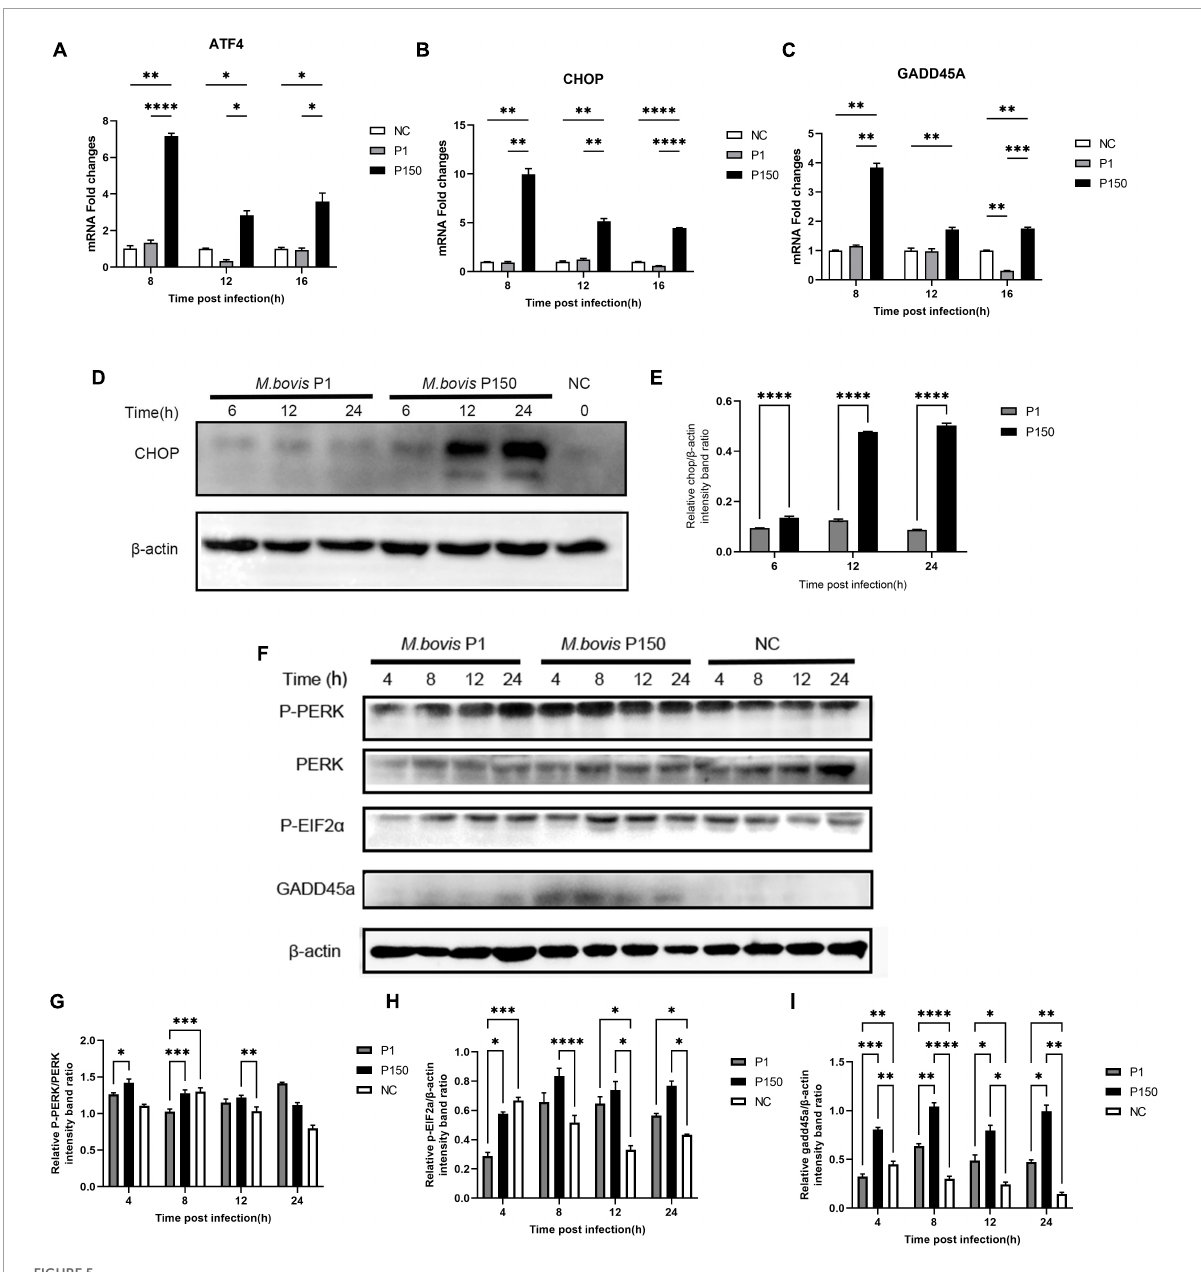
FIGURE5 Different expression of ER-stress responsive genes and proteins critical to PERK signal pathway in BoMac cells induced by M. bovis P1 and P150 strains. (A–C) The mRNA expression of ATF4, CHOP, and GADD45A, respectively, in PERK signal pathway at 8, 12, and 16 h post-infection by M. bovis P1 and P150 in BoMac cells using the qRT-PCR assay. Data are presented as the means ± SD of the results from three independent experiments. (D) Western blot assay indicated that CHOP was significantly increased in P150-infected cells at 6, 12, and 24 h post-infection compared to P1-infected. (E) Represents the relative intensity of western blot bands of panel D for expression of CHOP evaluated with ImageJ and normalized to β -actin. (F) The effect of M. bovis on target proteins in the PERK signal pathway was analyzed by western blot probed with specific antibodies. (G–I) Densitometry quantification of P-PERK, P-EIF2 α , and GADD45A was calculated by ImageJ analysis. Statistically significant difference was assessed by one-way ANOVA with Dunnett’s multiple-comparison test between P1 and P150 and annotated as follows: ∗ p < 0.05; ∗∗ p < 0.01; ∗∗∗ p < 0.001; and ∗∗∗∗ p <